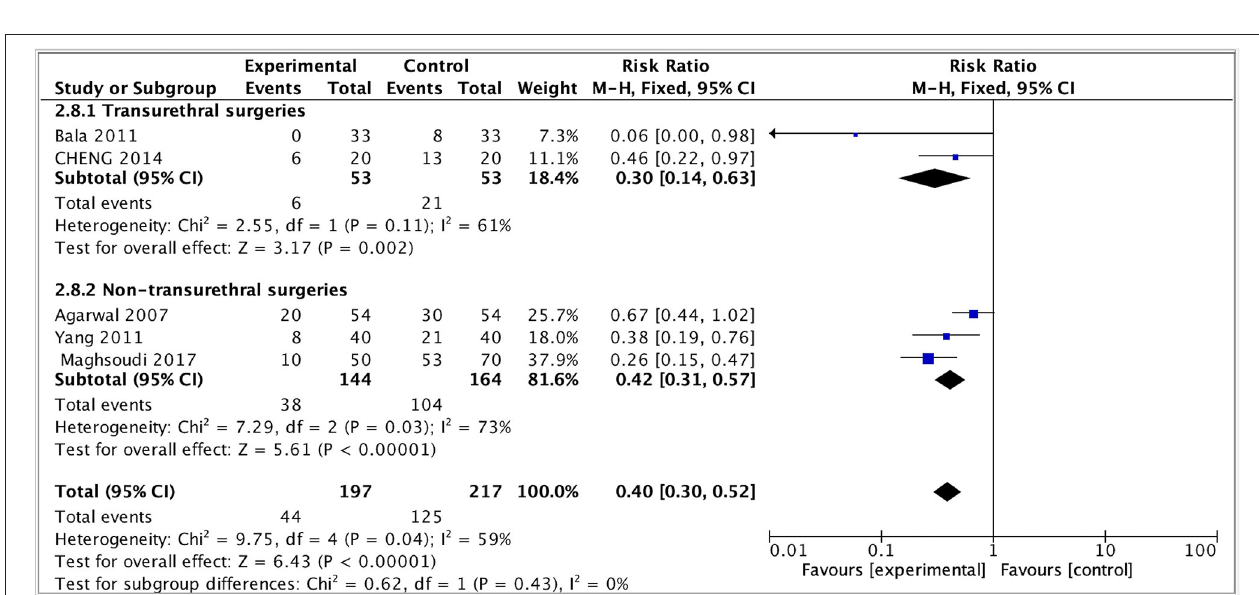
FIGURE 6 | Forest plot of adverse events. (A) Nausea and vomiting after surgery; (B) Dizziness after surgery.